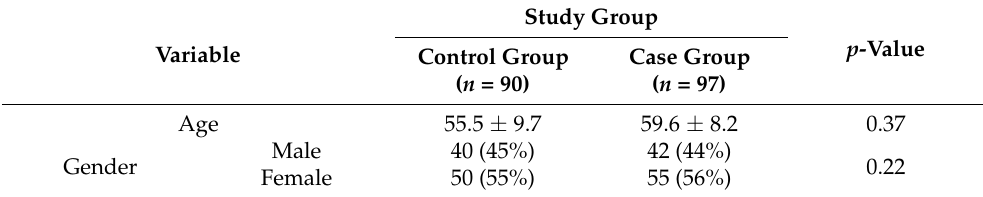
Table 1. Comparative analysis of baseline characteristics between the study groups.